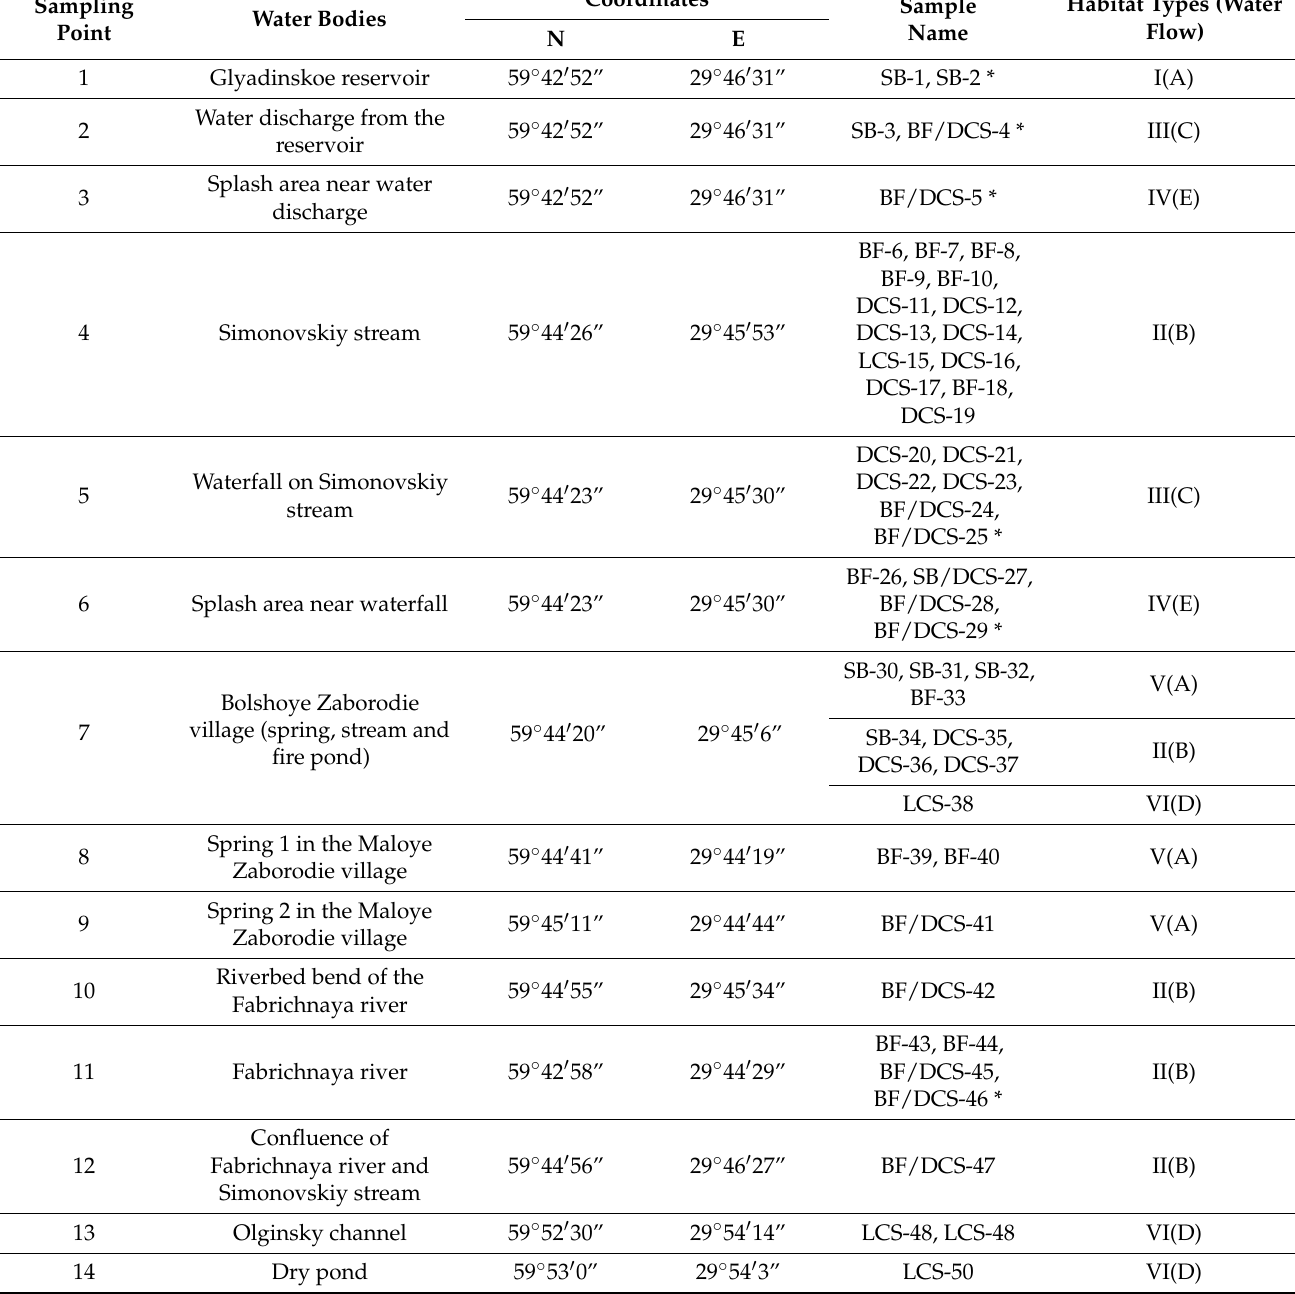
Table 1. Names and locations of samples, collected from Peterhof fountains water supply